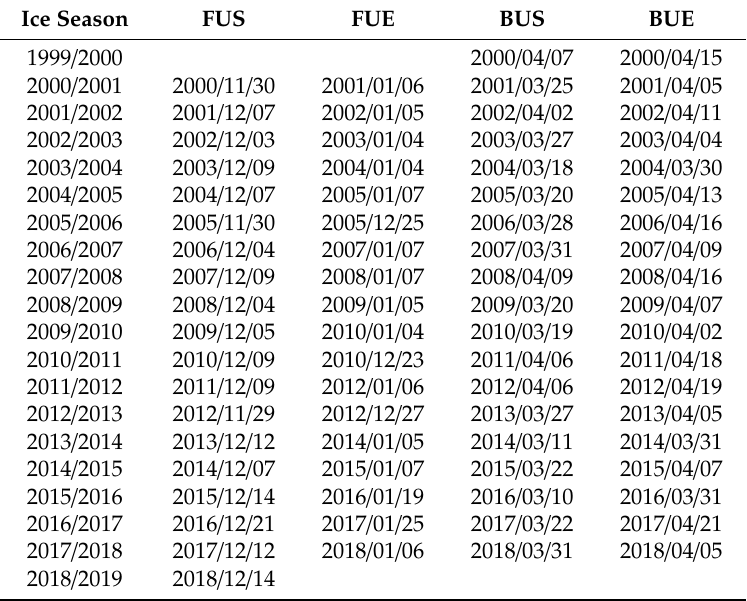
Table A3. The detailed freeze-thaw dates of Qinghai Lake from 2000 to 2018 (the MODIS data processed between 24 February 2000 and 31 December